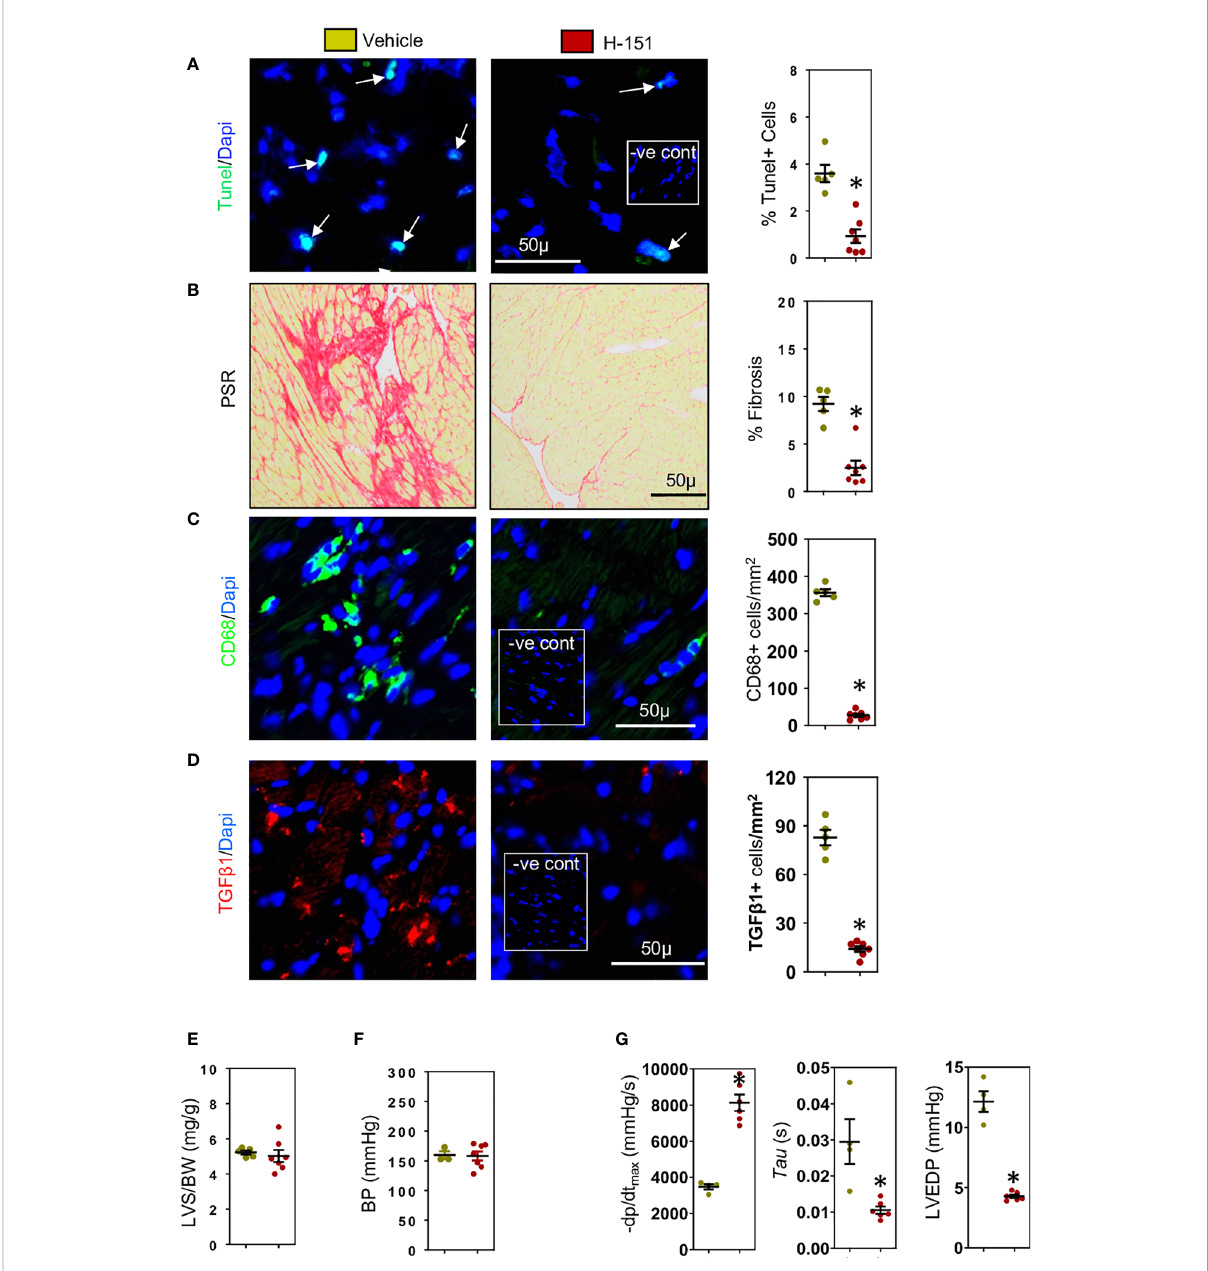
FIGURE 6 H-151, small molecule STING inhibitor, reduces cardiac fi brosis and improves left ventricular (LV) diastolic function. H-151 treatment markedly reduces (A) LV cell apoptosis and (B) LV fi brosis (PSR staining) in TAC mice. (C) LV CD68+ macrophages and (D) cells expressing TGF- b 1 are greatly reduced in H-151 treated mice. (E) LV hypertrophy (LVS/BW) and (F) systolic blood pressure (SBP) are not affected by H-151 treatment. (G) LV diastolic function is improved by H-151 treatment. Results are means ± SEM with small circles representing data from individual mice. n=7-9/group. -ve control; no primary antibody control, scale bar represents 50µm *P< 0.05 using two tailed Student ’ s t-test, comparing to